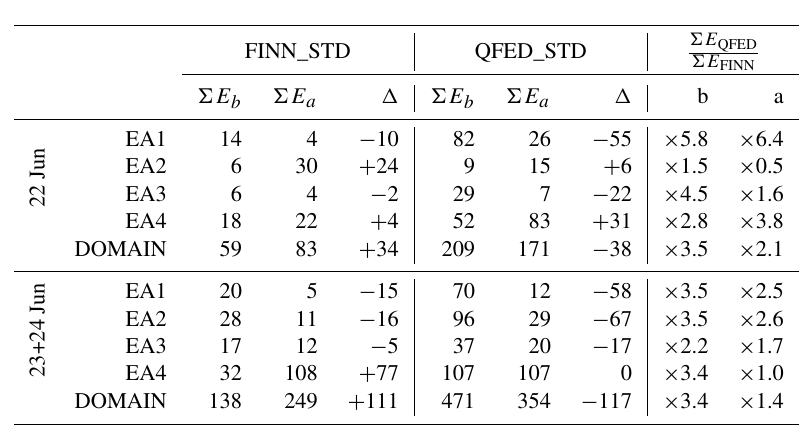
Table 5. Total BB emissions for EAs and domain-wide during the 22 and 23/24 June inversions (averaged for a 24h period). Absolute units are in Mg. Note that the differences ( (cid:49) ) may not sum due to rounding.